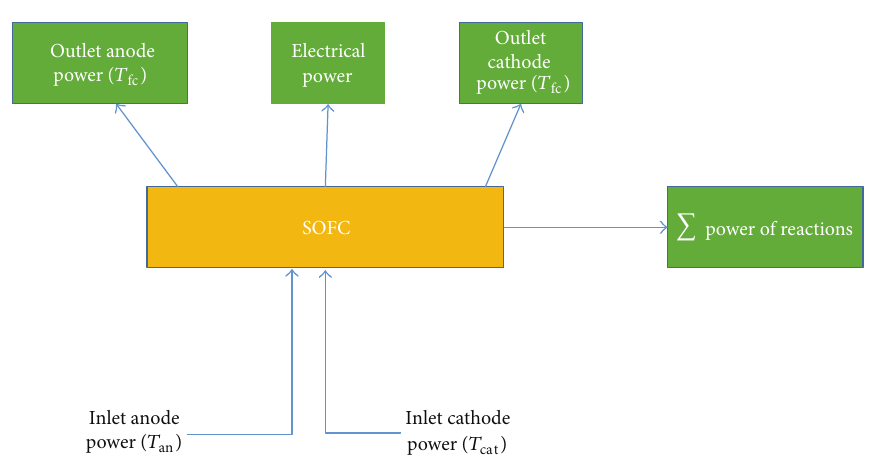
Figure 4: Flow input power and output from the fuel